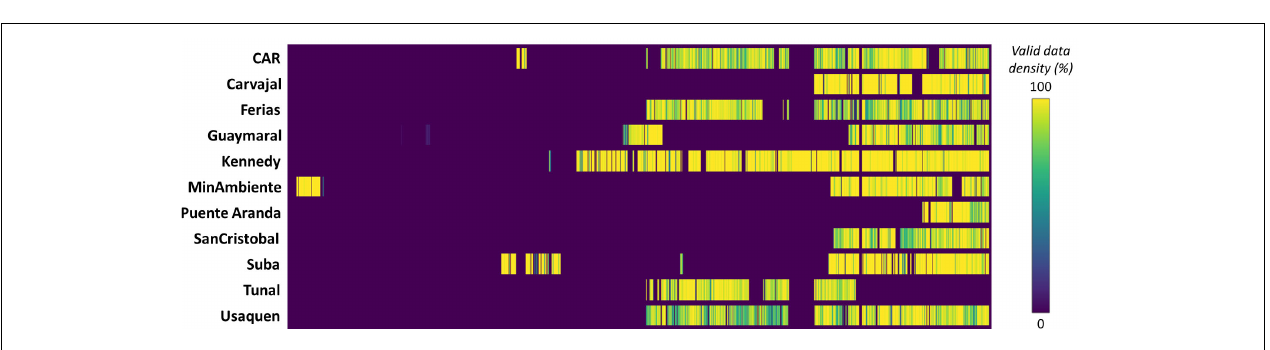
FIGURE 4 | Valid data density heatmap for PM 2 . 5 , 1998–2018.